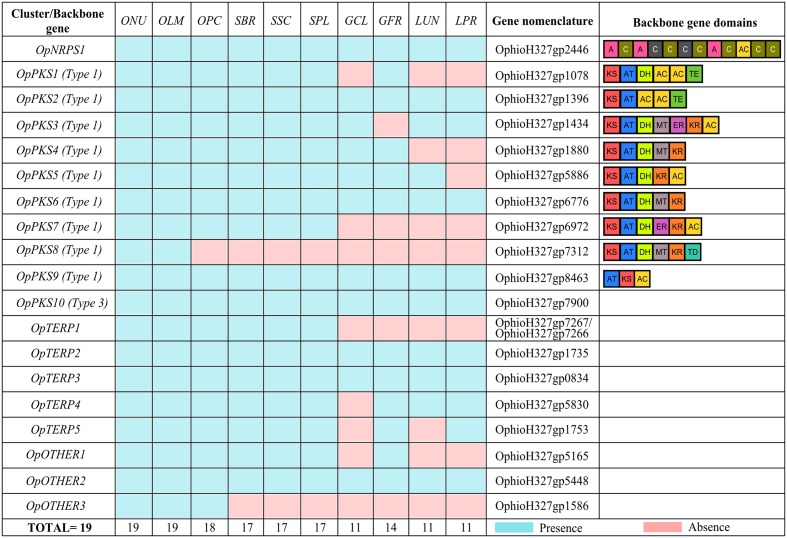
Biosynthetic gene cluster (BGC) conservation in the Ophiostomataceae family. O. novo-ulmi (ONU), O. ulmi (OLM), O. piceae (OPC), S. brasiliensis (SBR), S. schenckii (SSC), S. pallida (SPL), G. clavigera (GCL), G. fragrans (GFR), L. lundbergii (LUN), and L. procerum (LPR). Nomenclature adapted from Comeau et al. (2015) and domains for PKS and NRPS backbone gene are listed. Adenylation (A), Condensation (C), Peptidyl Carrier Protein (PCP), Keto-synthase (KS), Acyltransferase (AT), Acyl Carrier Protein (AC), Dehydrogenase (DH), Enoylreductase (ER), Ketoreductase (KR), Methyltransferase O- or C- (MT), Thioesterase (TE), Thioester reductase (TD). The conservation of predicted BGCs among Ophiostomataceae species was assessed using MultiGeneBlast 1.1.14 (analyses of genomic loci with predicted proteins) (Medema et al., 2013), based primarily on backbone gene conservation (e-value < 1 × 10-5, query coverage ≥ 50%, and identity ≥ 50%).